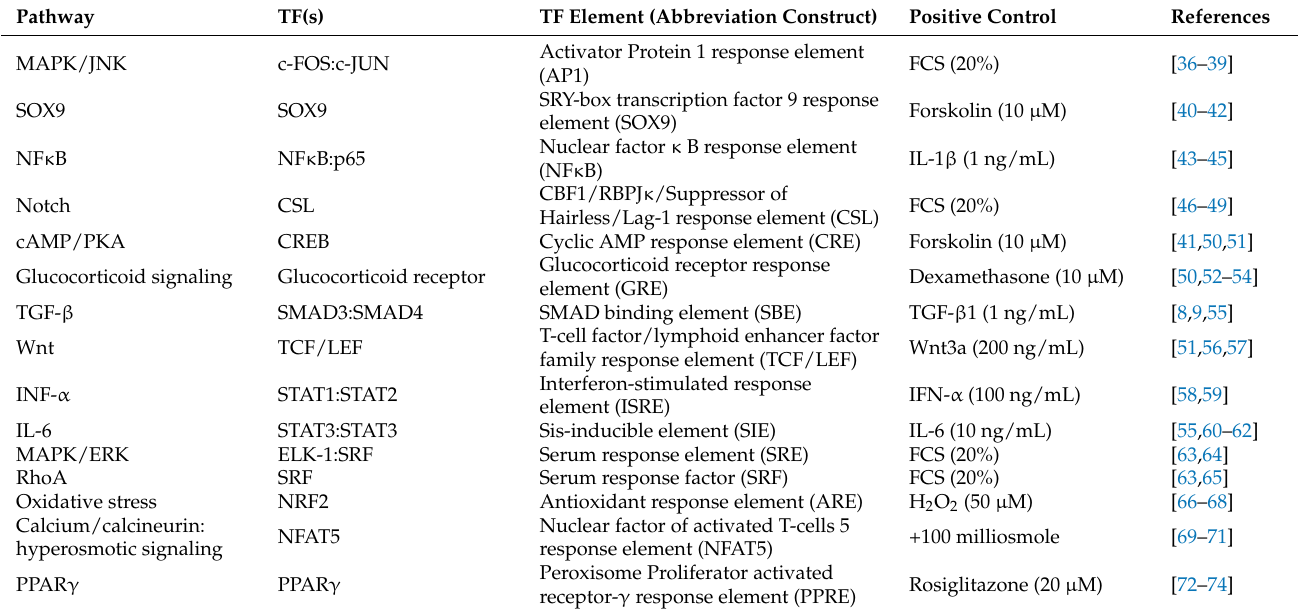
Table 1. Transcription factor (TF) elements used for luciferase TF activity constructs, each of them known to activate relevant chondrocyte signaling